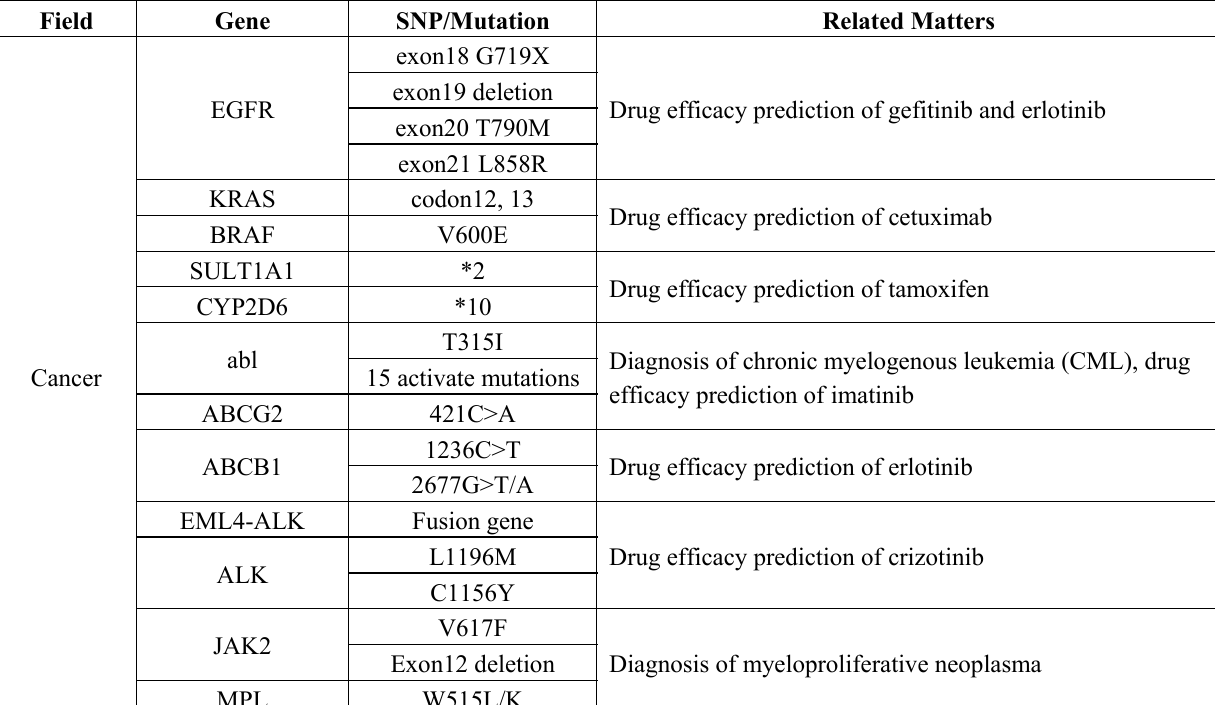
Table 1. Gene items measured with the i-densy TM